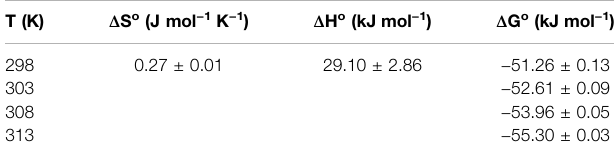
TABLE 6 | Thermodynamic parameters of the interaction between HSA and TBESD at different temperatures (Mean ± SD, n =